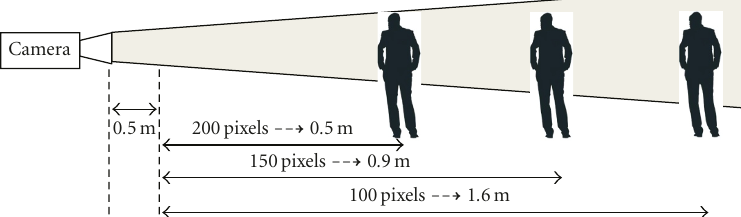
Figure 4: The figure illustrates the varying depths of the capture volume based on the minimum iris resolution required. The iris resolution is indicated in terms of the number of pixels obtained across the iris in the capture eye image. The number to the right of the respective resolution indicates the depth of the capture volume in each case. 0.5 meters is the theoretical minimum focusing distance as determined in Section 2.1. We see that for minimum iris resolutions of 200, 150 and 100 pixels, the respective capture volume depths are 0.5 meters, 0.9 meters, and 1.6 meters. These results are based on analysis done using (1), (2), and